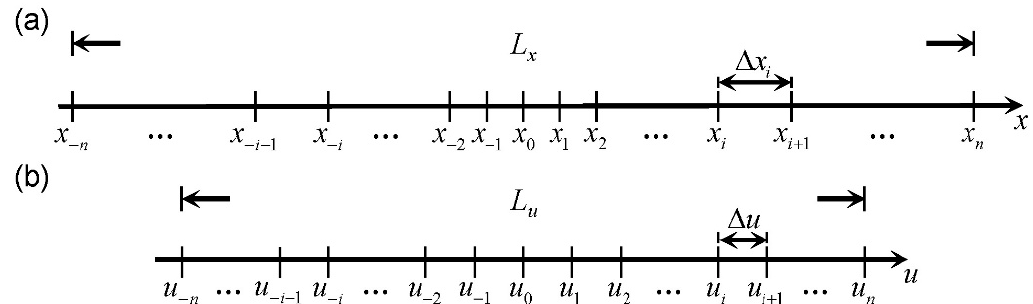
Figure 1. ( a ) Number of 2 n grids, with various cell sizes, are distributed in the x coordination with length L x , where { x − n , . . . , x i , . . . , x n } defines the domain of each grid, and i is an integer from – n to n ; for a grid centered at x i +1/2 = ( x i + x i +1 )/2, the physical cell size is ∆ x i = ( x i +1 − x i ). ( b ) Number of 2 n grids, each with the constant cell size ∆ u , are distributed in the u coordination with length L u , where the points { u − n , . . . , u i , . . . , u n } define the domain of each grid. The length L u are decided by the designated mapping function u = f ( x ).